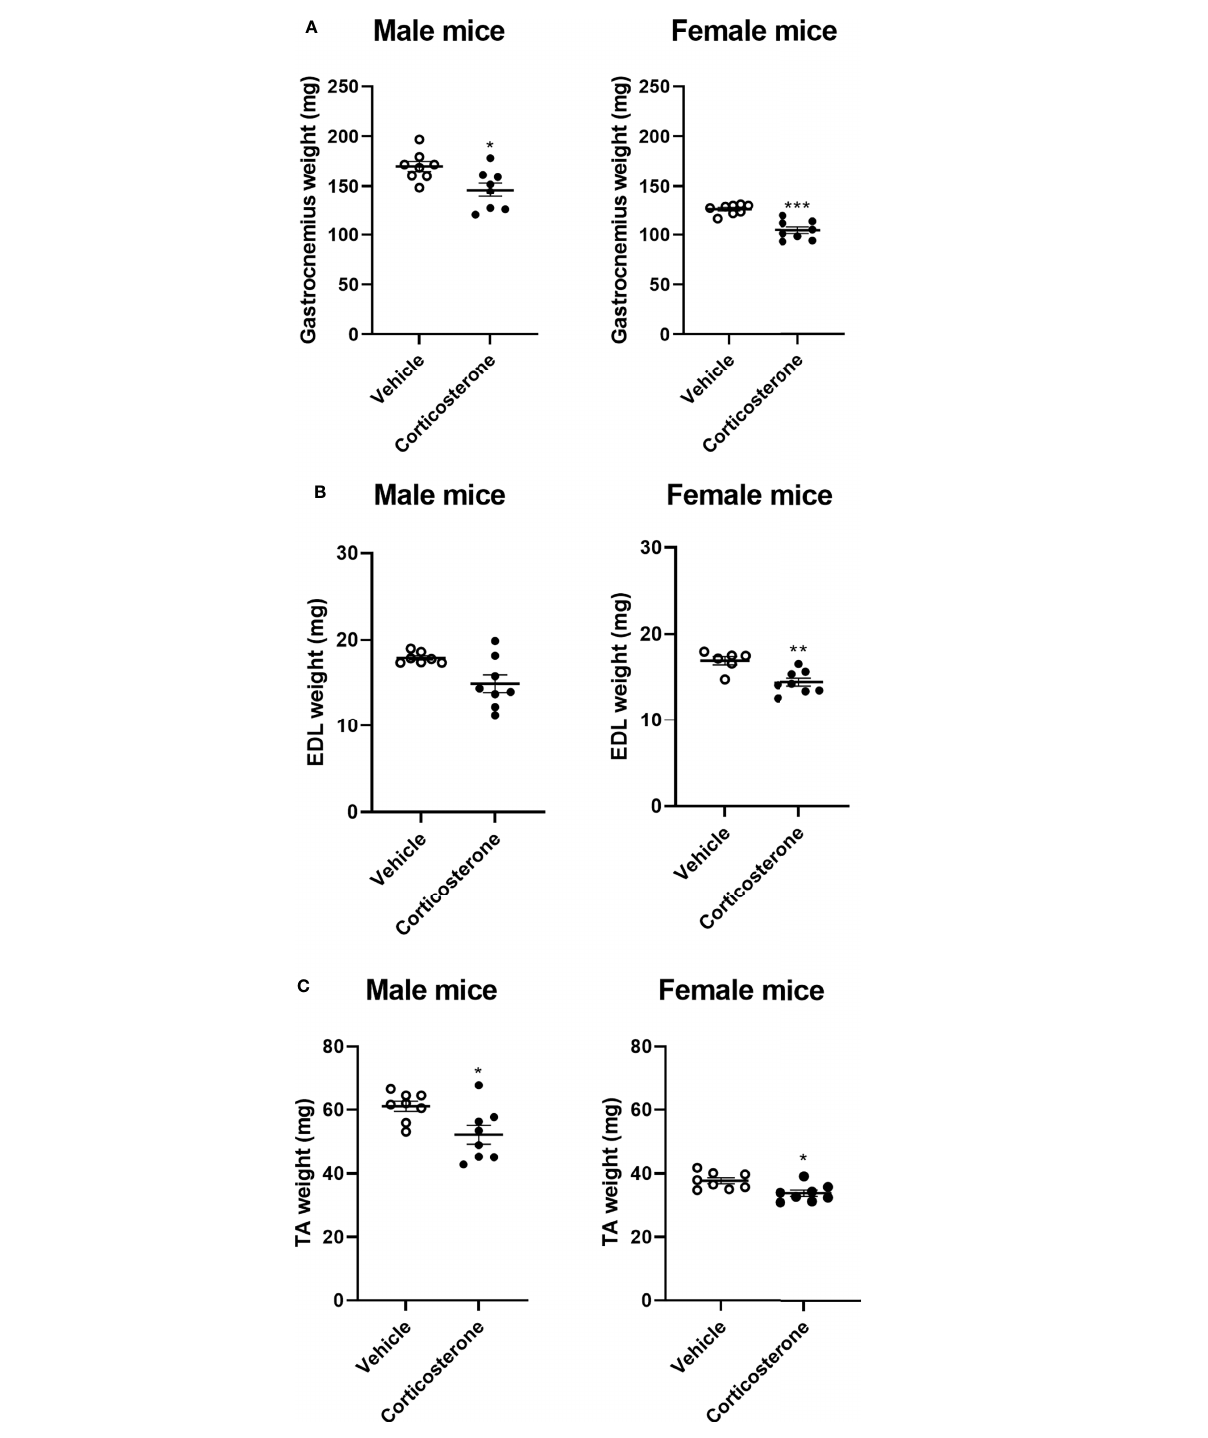
Frontiers in Endocrinology |